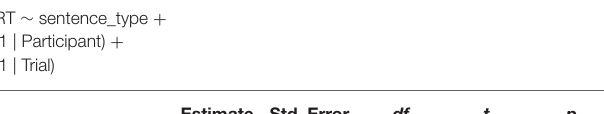
TABLE 2 | The best fitting model and its parameter estimates predicting RT in the same condition in Experiment 1. RT ∼ sentence_type + (1 | Participant) +